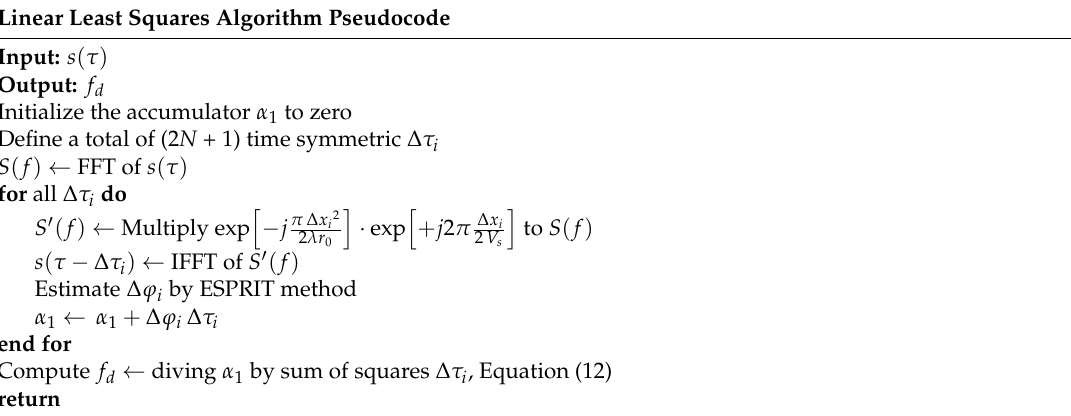
Table 1. Pseudocode of the proposed